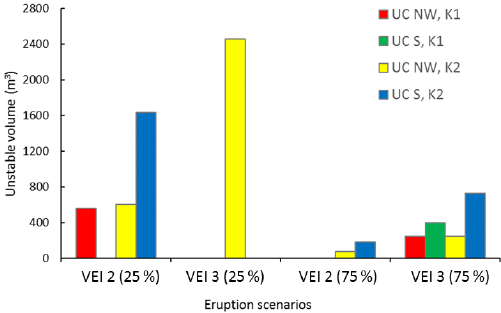
Figure 9. Unstable tephra fallout volume for the S and NW up- per catchments obtained with TRIGRS for the subplinian scenarios VEI 2 and VEI 3 with K s = 1 × 10 − 2 ms − 1 (from the literature) and for VEI2 and VEI3 with K s = 6 . 8 × 10 − 4 ms − 1 (as measured in the field) for probabilities of occurrence of 25% and